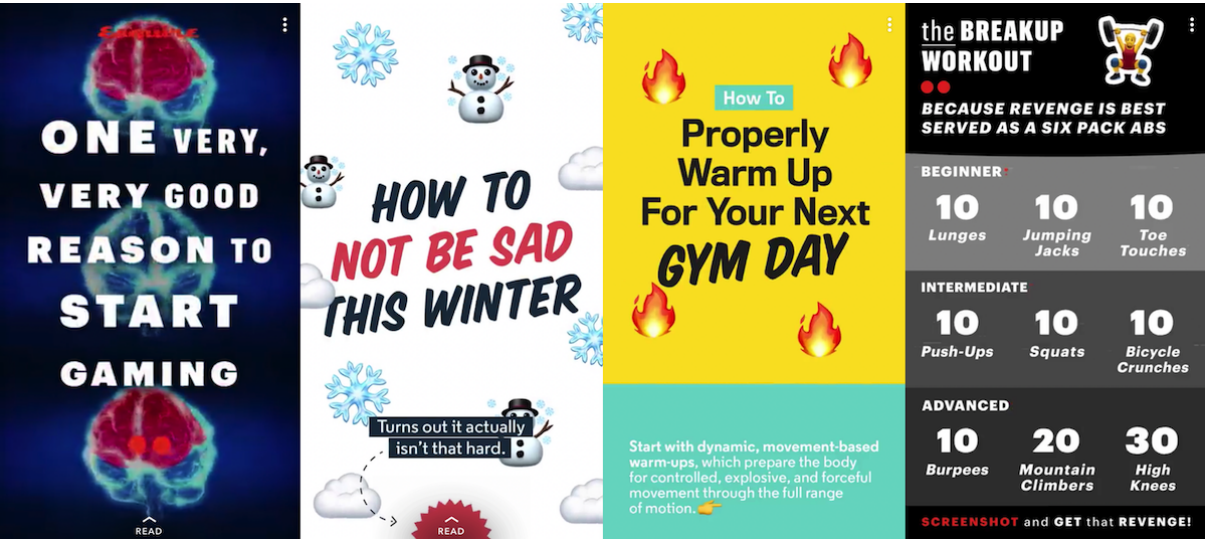
Figure 1. Examples of general health topics posted to male-focused Discover channels.